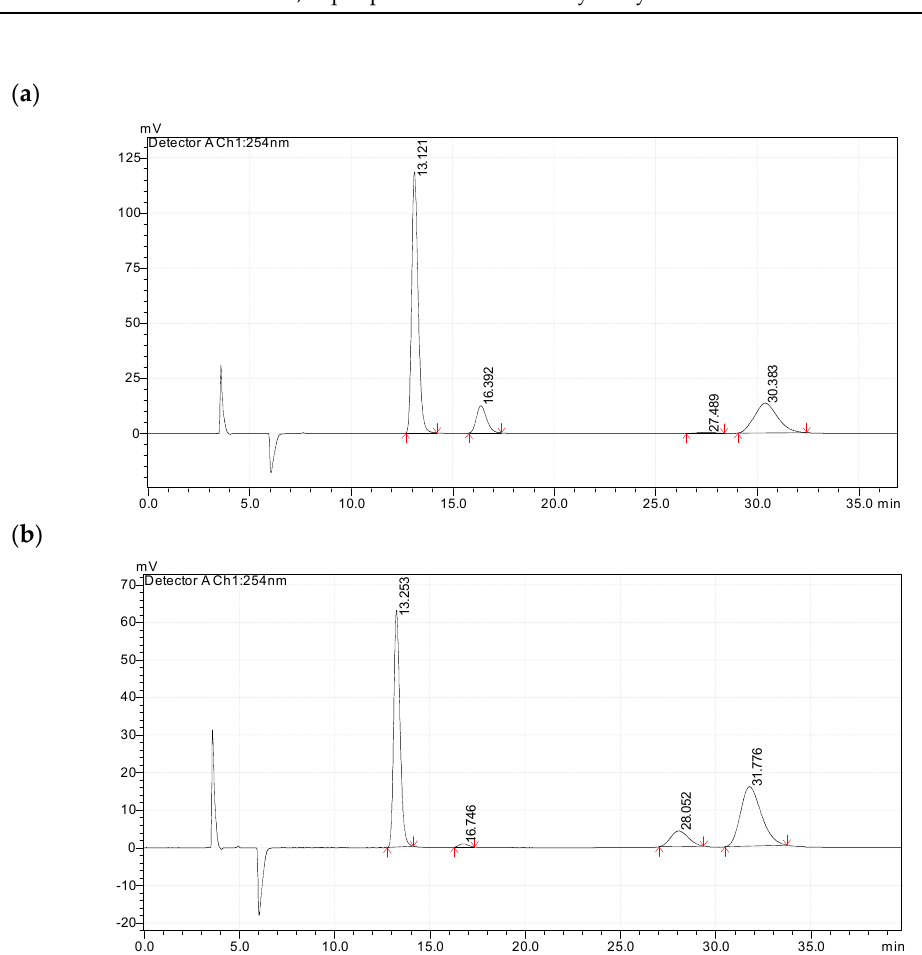
Figure 1. High-performance liquid chromatography (HPLC) chromatograms of ( R , S )-flurbiprofen and its methyl esters. ( a ) ( R , S )-flurbiprofen and its methyl ester, reaction time 46 h, IB-150A, DCE; t R 13.121 ( R )-enantiomer of methyl ester, t R 16.392 ( S )-enantiomer of methyl ester, t R 27.489 ( R )-flurbiprofen, t R 30.383 ( S )-flurbiprofen; ( b ) ( R , S )-flurbiprofen and its methyl ester, reaction time 96 h, IB-S861, DCM; t R 13.253 ( R )-enantiomer of methyl ester, t R 16.746 ( S )-enantiomer of methyl ester, t R 28.052 ( R )-flurbiprofen, t R 31.176 ( S )-flurbiprofen; Chromatographic conditions: Lux Cellulose-3 (4.6 mm × 250 mm × 5 µ m) column; mobile phase: n -heptane / 2-propanol / trifluoroacetic acid (97.6 / 2.4 / 0.2 v / v / v ), flow rate = 1 mL/min, t = 15 °C, UV = 254 nm.